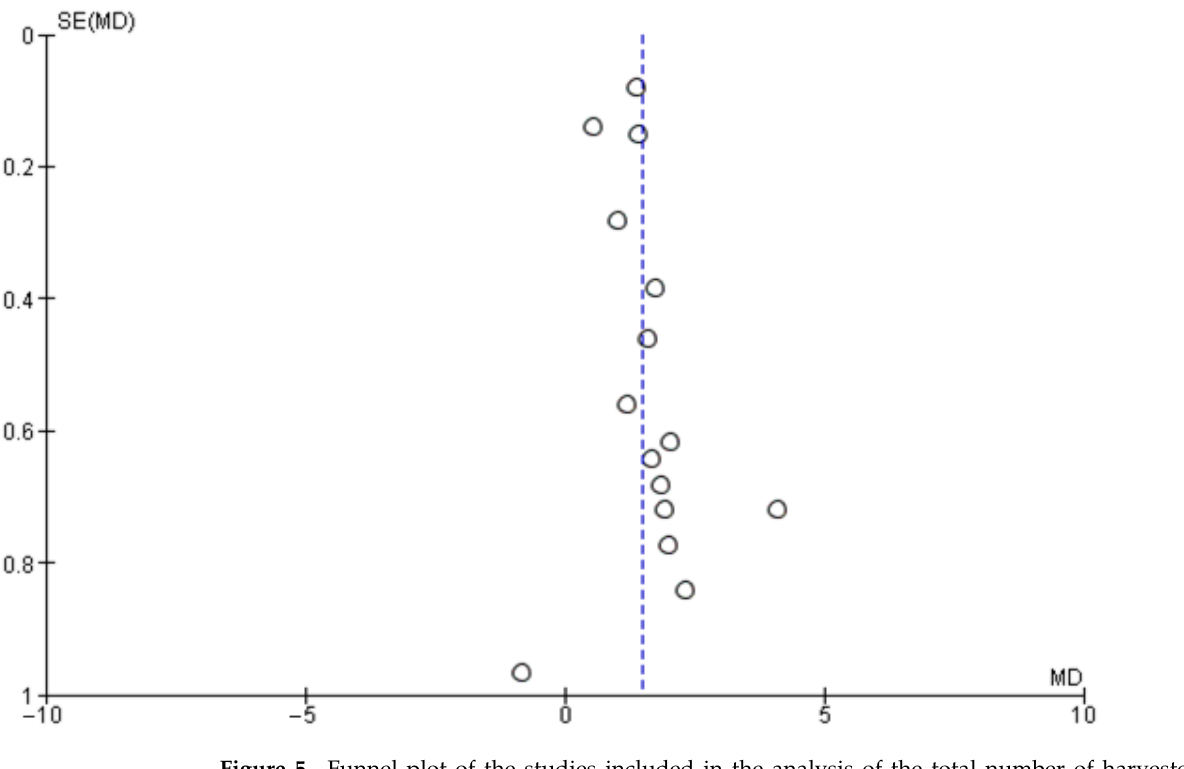
Figure 5. Funnel plot of the studies included in the analysis of the total number of harvested lymph nodes.